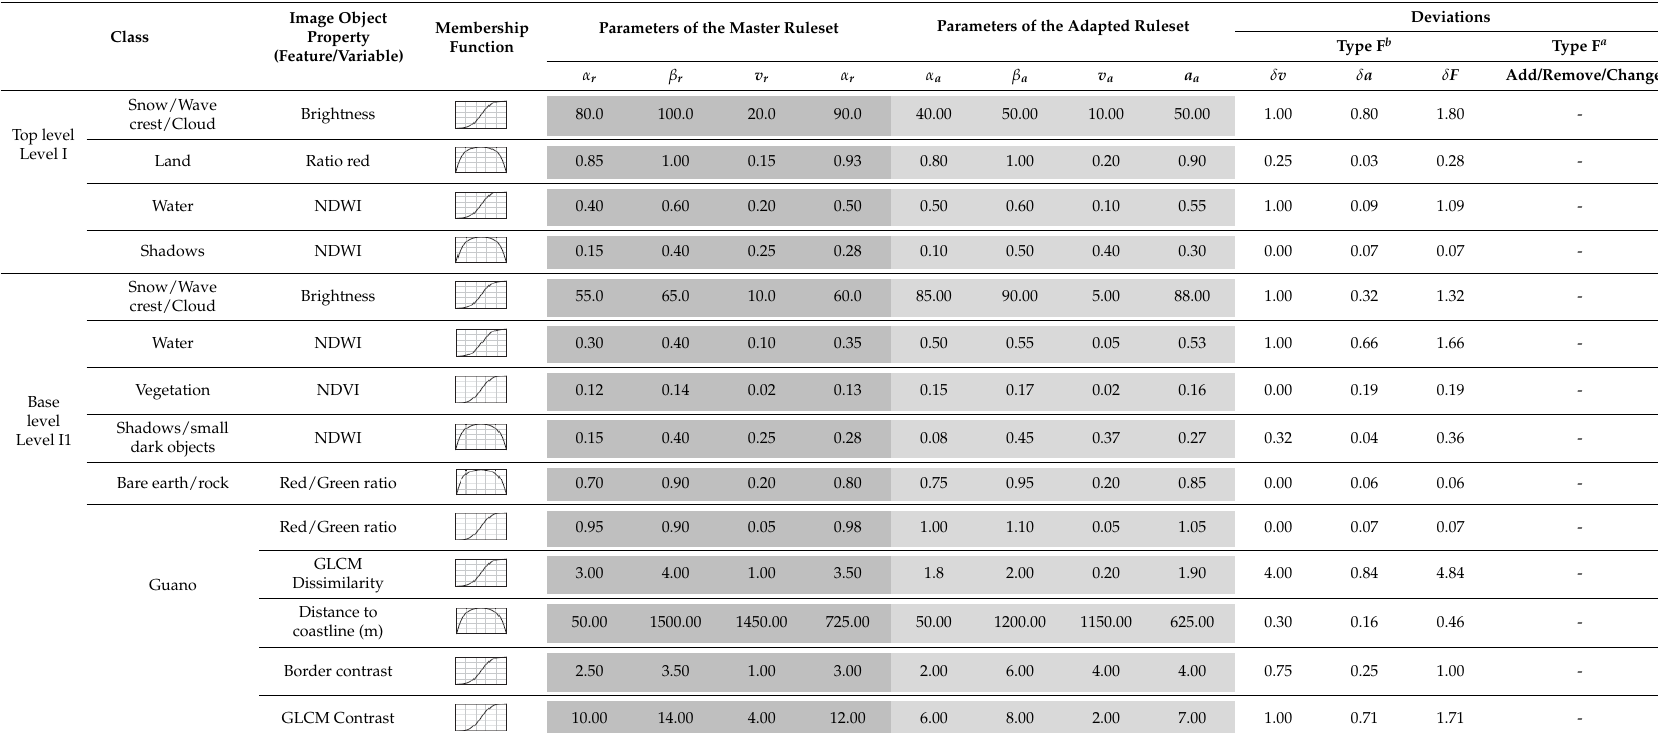
Table 7. Ruleset adaptation from HOPE to PAUL.